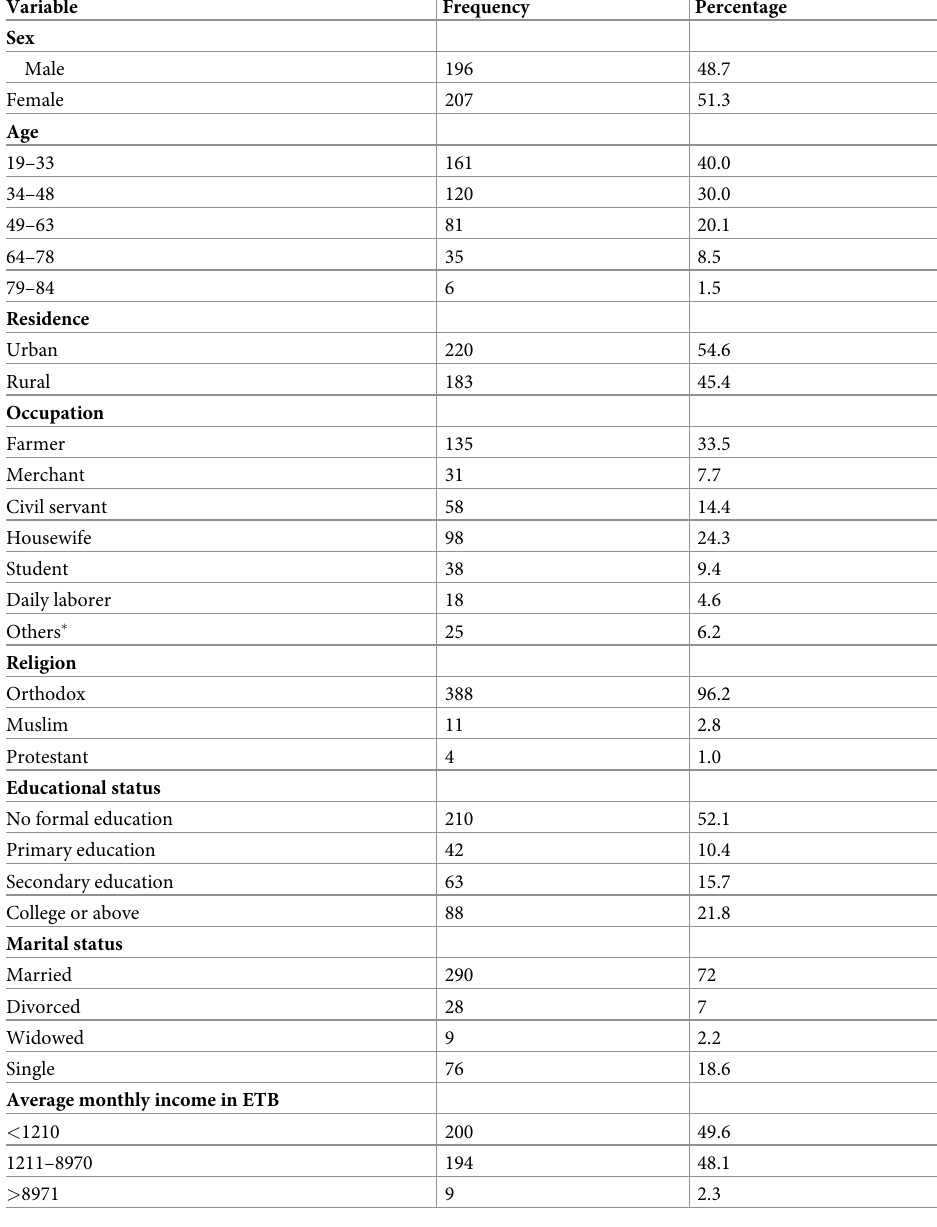
Table 1. Socio-demographic characteristics of adult patients visiting surgical OPD at the UOG Comprehensive Hospital, Ethiopia, 2020 (n = 403).